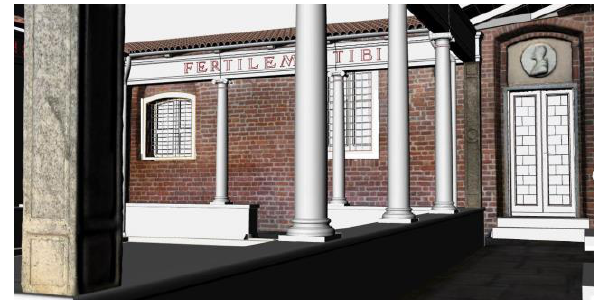
Figure 8. Complete model of the cloister